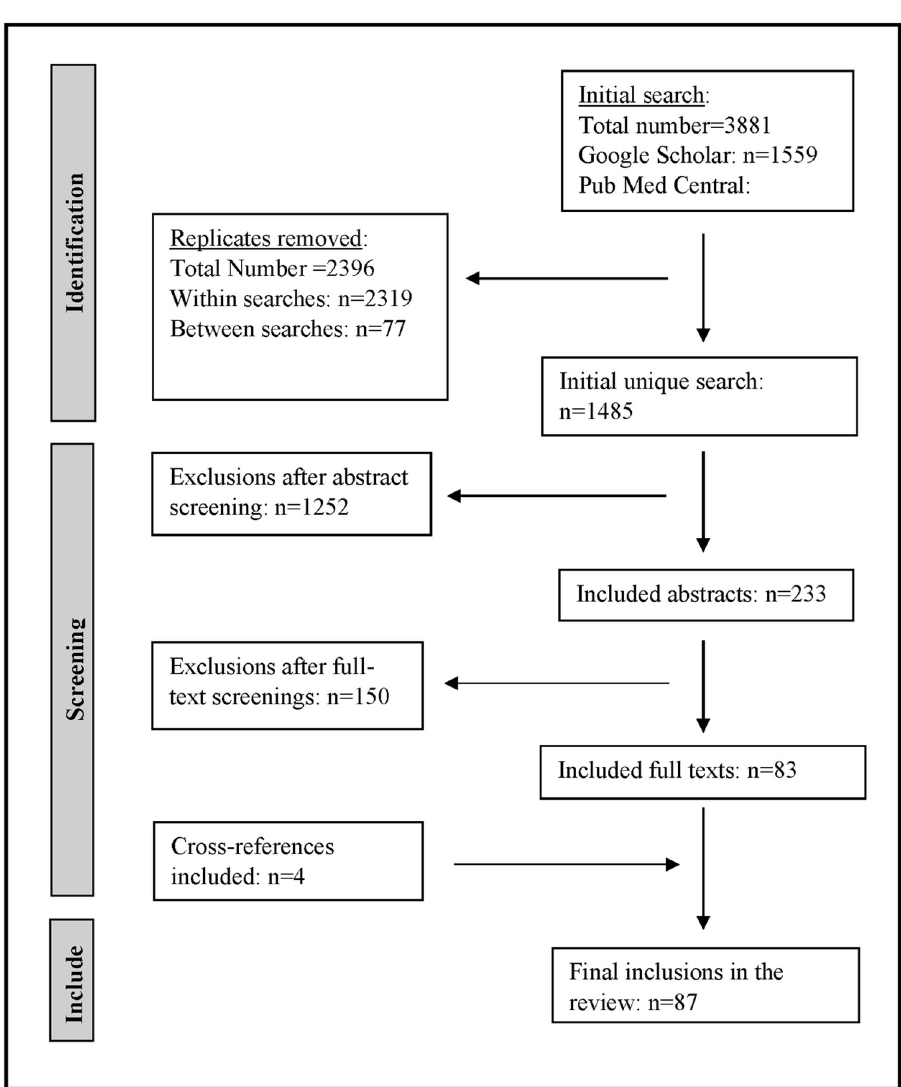
Fig 2. Flow diagram for included publications of the two search engines (Google Scholar and PubMed Central) to identify mosquito control action thresholds reported across the